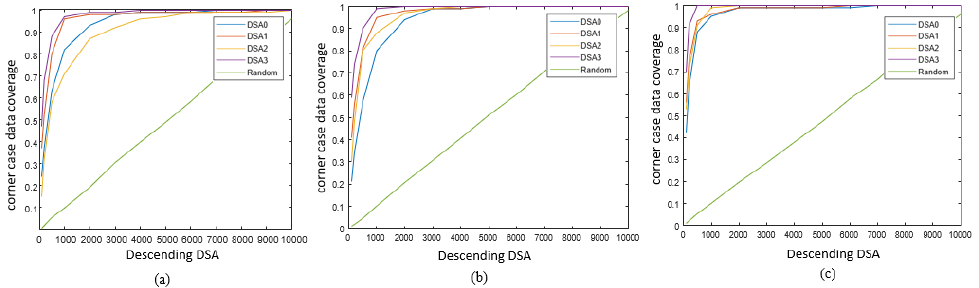
Figure 8. Corner case data coverage of testing data sorted as the descending DSA. ( a ) Layer1. ( b ) Layer2. ( c )